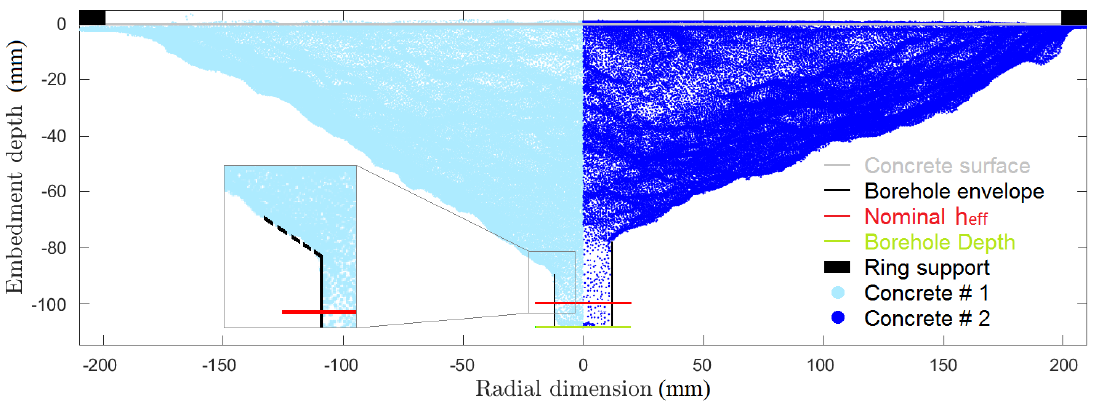
Figure 2. Comparison of point clouds acquired for two craters and test set-up representation.